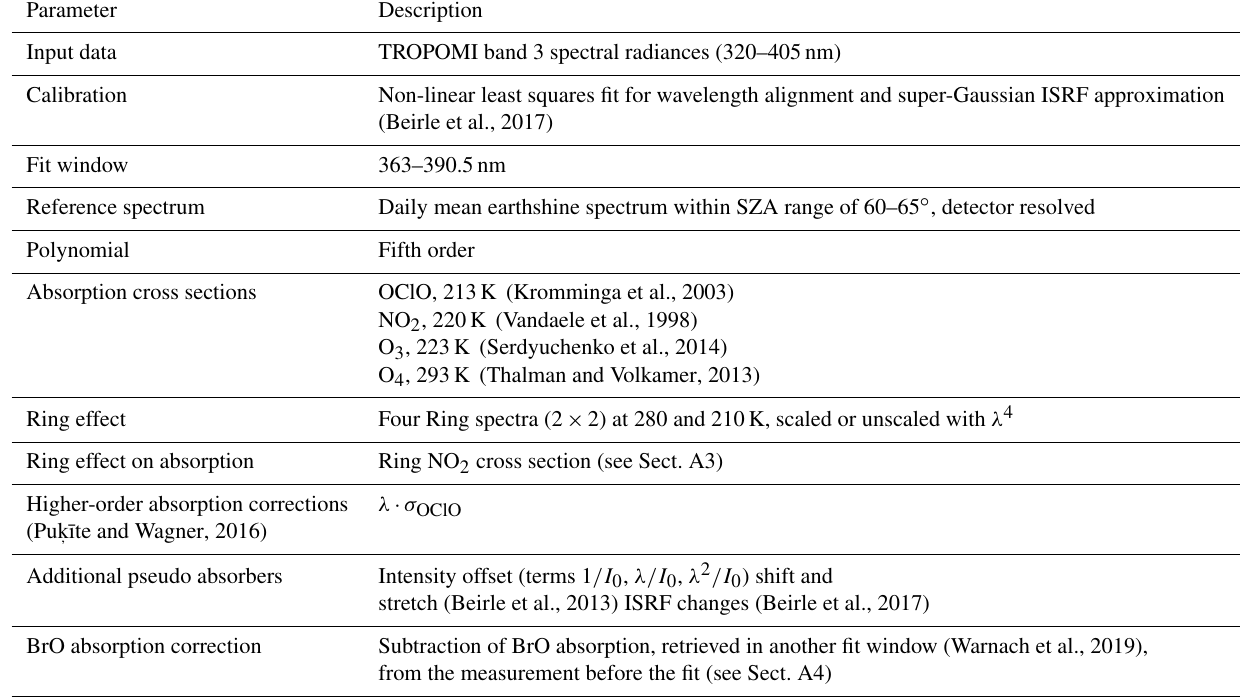
Table 1. Retrieval settings for OClO SCD